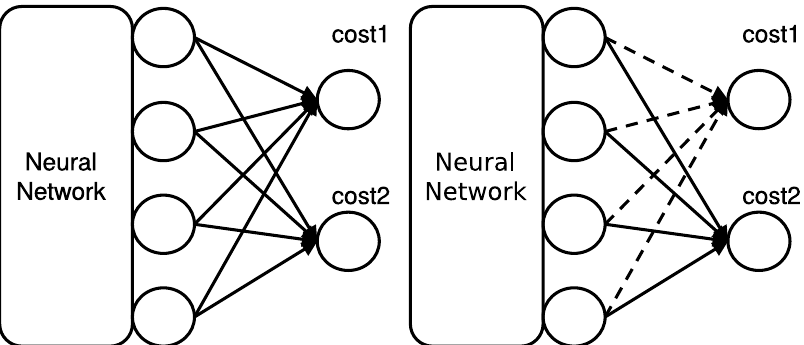
Figure 2. A schematic illustration of the Cost-Out mechanism. ( left ) Typical multi-task learning scheme learns all sub-costs per each update. ( right ) Cost-Out randomly drops the sub-costs with a given probability and learns only the remaining sub-costs per each update. The dotted line and solid line indicates dropped sub-cost and remaining sub-cost